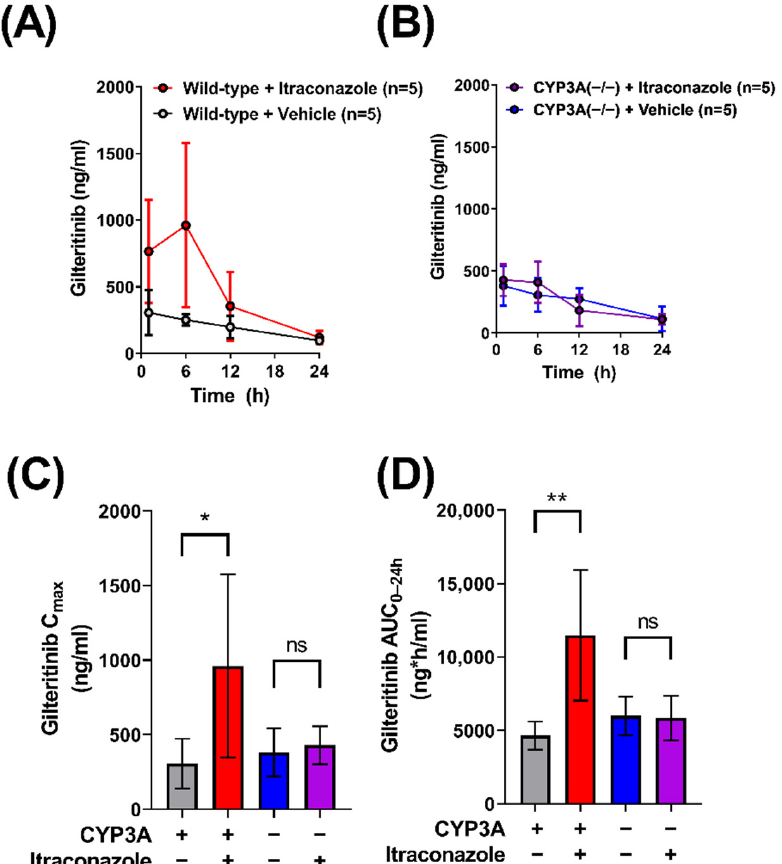
Figure 1. Itraconazole-related increases in gilteritinib exposure are dependent on CYP3A function, but not necessarily CYP3A inhibition. Plasma concentrations of gilteritinib in ( A ) wild-type mice and ( B ) CYP3A( − / − ) mice with or without itraconazole (100 mg/kg) given 30 min before gilteritinib (10 mg/kg). Samples were analyzed via LC-MS/MS. The maximum observed concentration (C max ) ( C ) and area under the concentration–time curve (AUC) ( D ) from time zero to the last collected and 24 h (AUC 0–24h ) were calculated with non-compartmental analysis using Phoenix WinNonlin 8.1. Data are shown as mean (bars) and SD (error bars). * p < 0.05, ** p < 0.01. ‘ns’ denotes not statistically